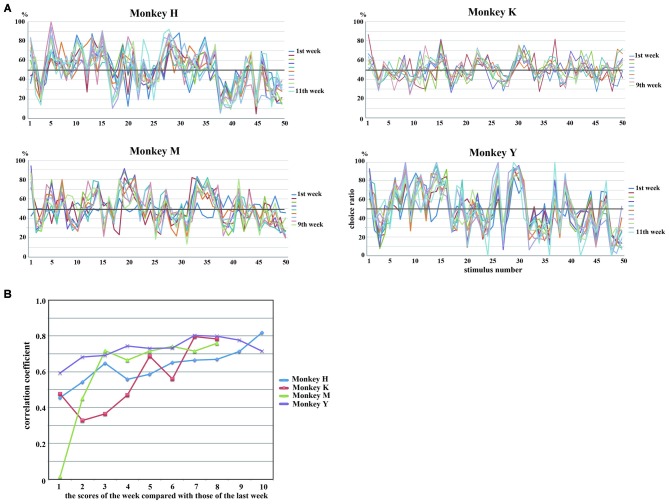
(A) Weekly changes in choice ratios of 50 stimuli across consecutive weeks. Lines of different colors indicate data obtained in different weeks. Although the choice ratio changed for some stimuli, the overall patterns of the weekly values of choice ratios for the 50 stimuli were maintained across consecutive weeks in all of the monkeys. (B) Temporal changes of correlation coefficients calculated between choice ratios of 50 stimuli obtained in each week and those obtained in the last week of the behavioral experiment. Statistically significant positive correlations (p < 0.01) were continuously observed across whole examined weeks in Monkeys H, K and Y and from the second week to the last week in Monkey M. Correlations gradually increased with time in all monkeys. Different colors indicate the results of different monkeys.